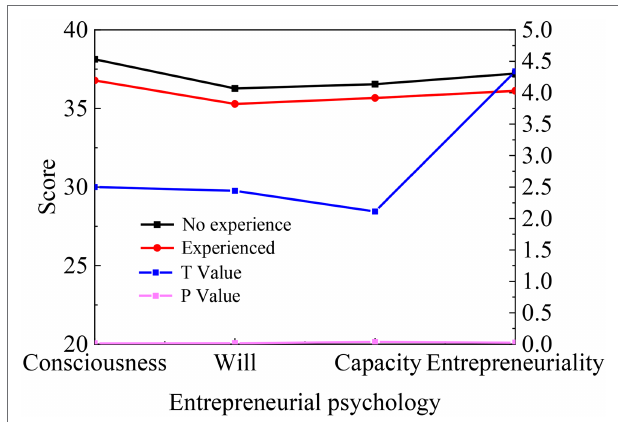
FIGURE 6 | Statistics of differences of College Students’ entrepreneurial psychology in the entrepreneurial